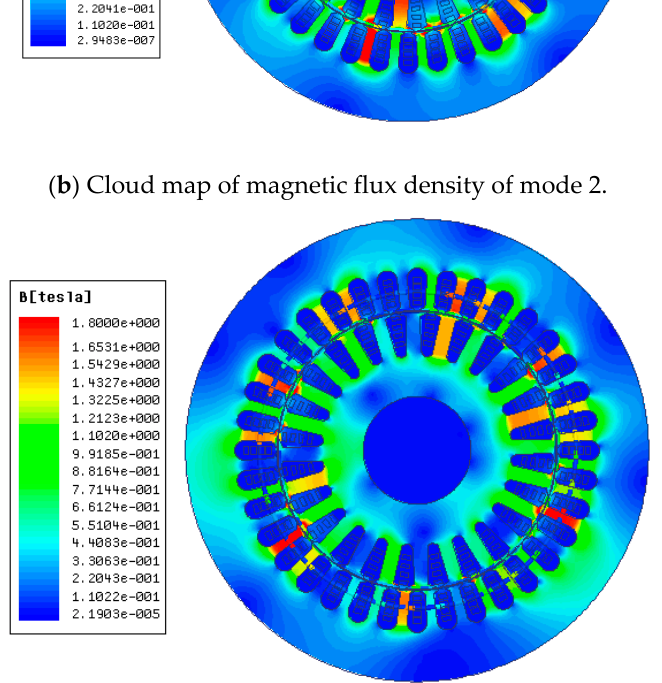
Figure 15. Cloud map of magnetic flux density.